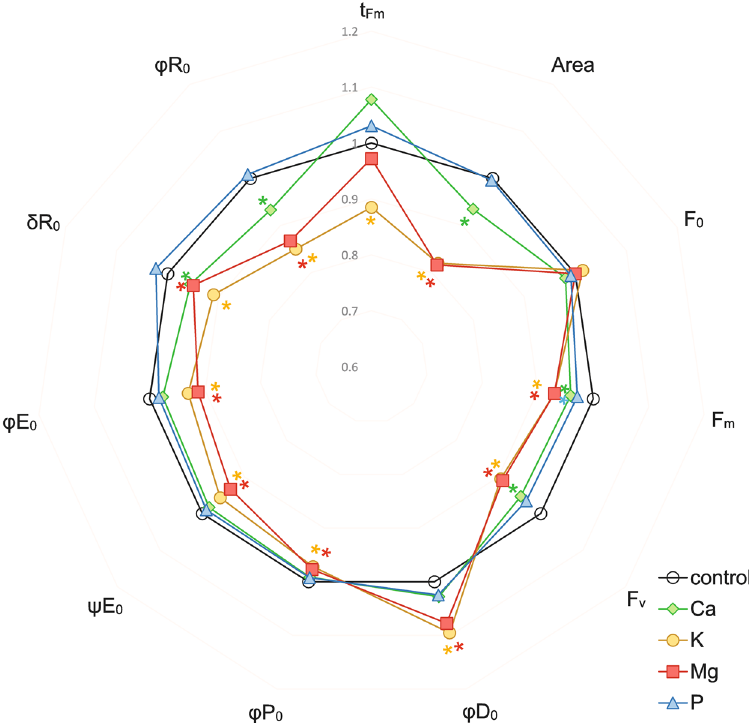
Figure 2. Relationships between parameters describing fluorescence and yield of photosystem II under macronutrient deprivation. Values are means (n = 55) after standardization. Asterisks describe significant differences compared with the control, using LSD test (P < 0.05). Parameters: t Fm − time (in ms) to reach maximum fluorescence F m ; Area − the area above the chlorophyll fluorescence curve between F 0 and F m (reflecting the size of the plastoquinone pool); F 0 − minimum fluorescence; F m − maximu m fluorescence; F v − maximum variable fluorescence; ϕ P 0 − maximum quantum yield of the primary PSII photochemistry; Ψ E − probability (at time 0) that a trapped exciton moves an electron into the electron transport chain beyond 0 Q A –; ϕ E 0 − quantum yield for electron transport from Q A – to plastoquinone; δ R 0 − probability with which an electron from the intersystem electron carriers will move to reduce the end acceptors at the PSI acceptor side; ϕ R − quantum yield for the reduction of the end electron acceptors at the PSI acceptor side; ϕ D 0 yield (at t = 0) of energy